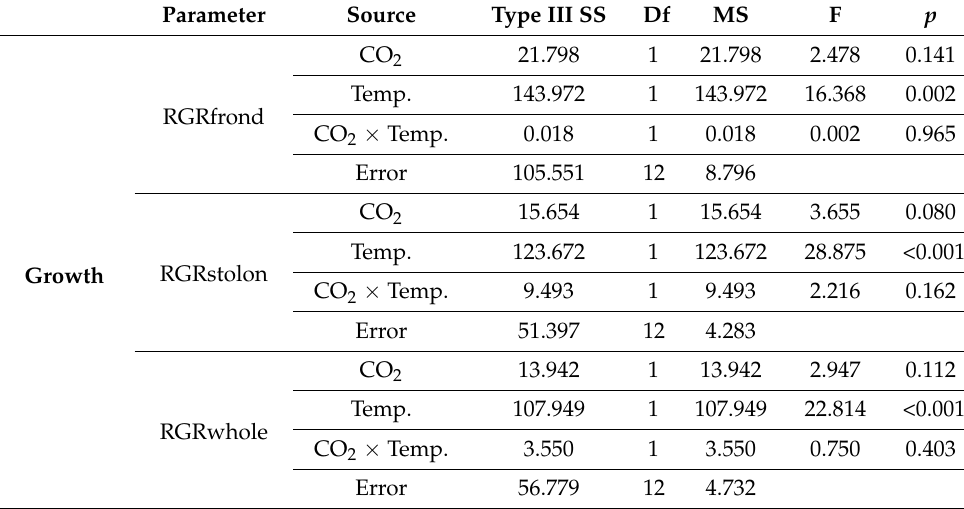
Table 4. Two-way ANOVAs to evaluate the individual and combined effects of CO 2 and temperature on relative growth rate (RGR) of Caulerpa sertularioides